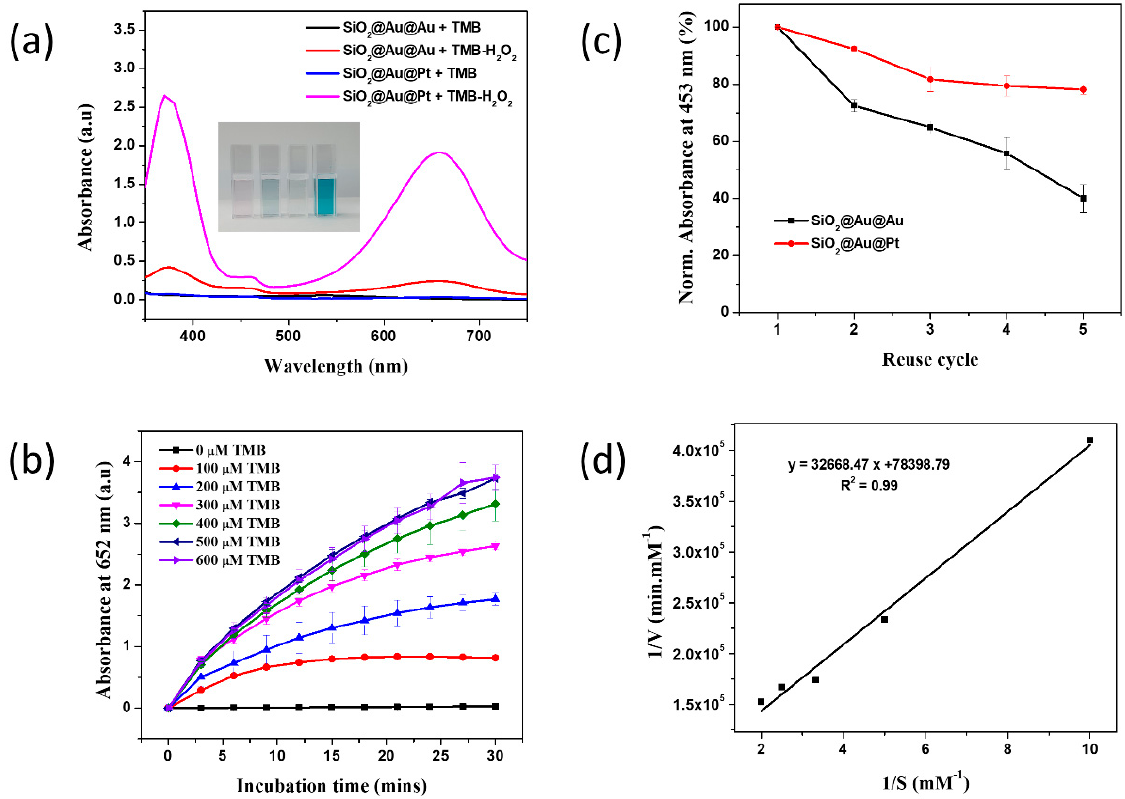
Figure 2. ( a ) UV-Vis absorbance spectroscopy of SiO 2 @Au@Pt and SiO 2 @Au@Au (5 µg) in TMB and in TMB-H 2 O 2 solutions. The inset shows the colors of the solutions. ( b ) The absorbance of recycled SiO 2 @Au@Au and SiO 2 @Au@Pt is shown in a TMB-H 2 O 2 solution. ( c ) UV-Vis absorbance spectroscopy and ( d ) Lineweaver-Burk plot at 652 nm for 5 µg SiO 2 @Au@Pt in a TMB-H 2 O 2 solution (0–600 µM TMB).